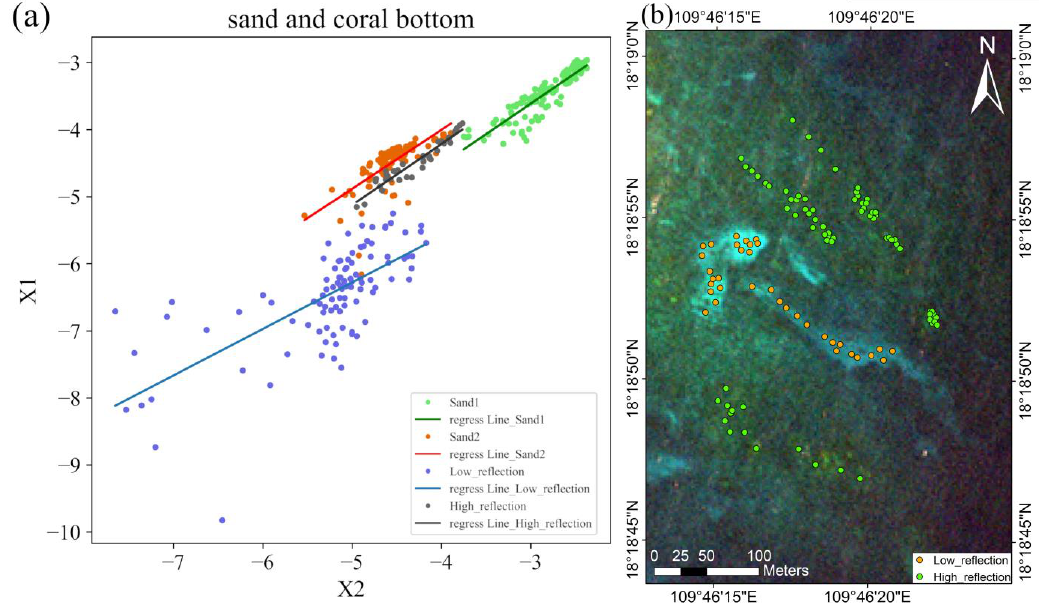
Figure 11. Intercept representing different substrates. ( a ) Different substrate types points selection ( b ). The location of selected points for substrates with high reflectance and substrates with low reflectance.